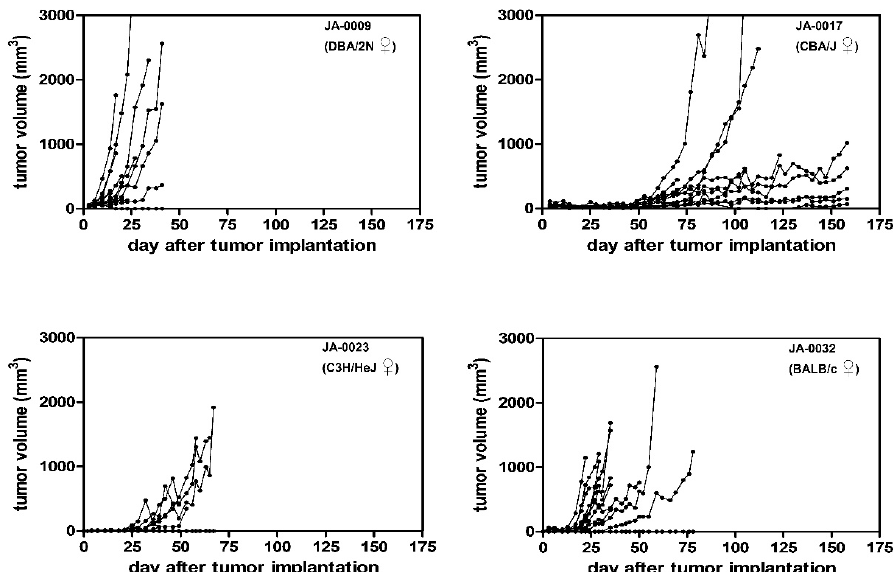
Figure 4. Take rates and growth curves of the selected sMDI models. Growth curves of 12 individual mice each implanted with previously frozen tumor pieces are shown for the sMDI models JA-0009, JA-0017, JA-0032, and JA-0023 (with tissue originating from a primary back tumor) in syngeneic female DBA/2N, CBA/J, BALB/c, and C3H/HeJ mice, respectively. Tumor growth was measured twice weekly with calipers.